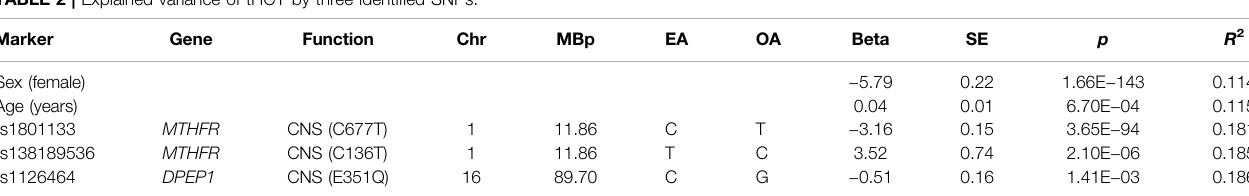
TABLE 2 | Explained variance of tHCY by three identi fi ed